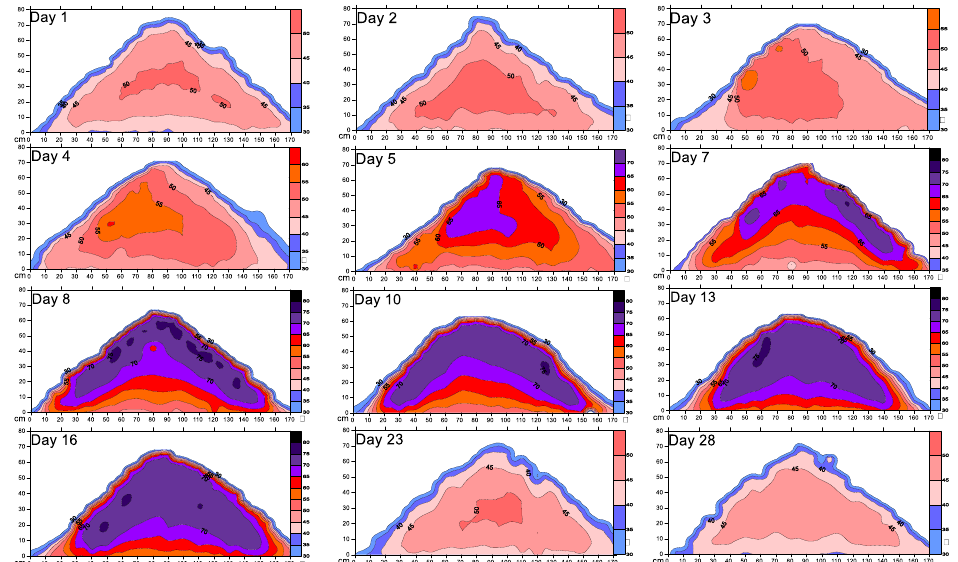
Figure 5. 2D temperature contour plots of the compost pile at different incubation days.